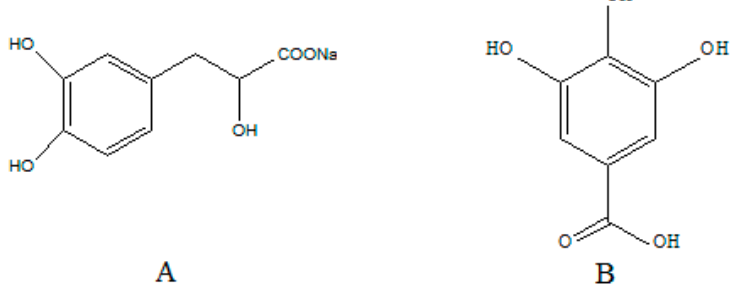
Figure 1. Chemical structures of sodium danshensu ( A ) and gallic acid (IS, B ).